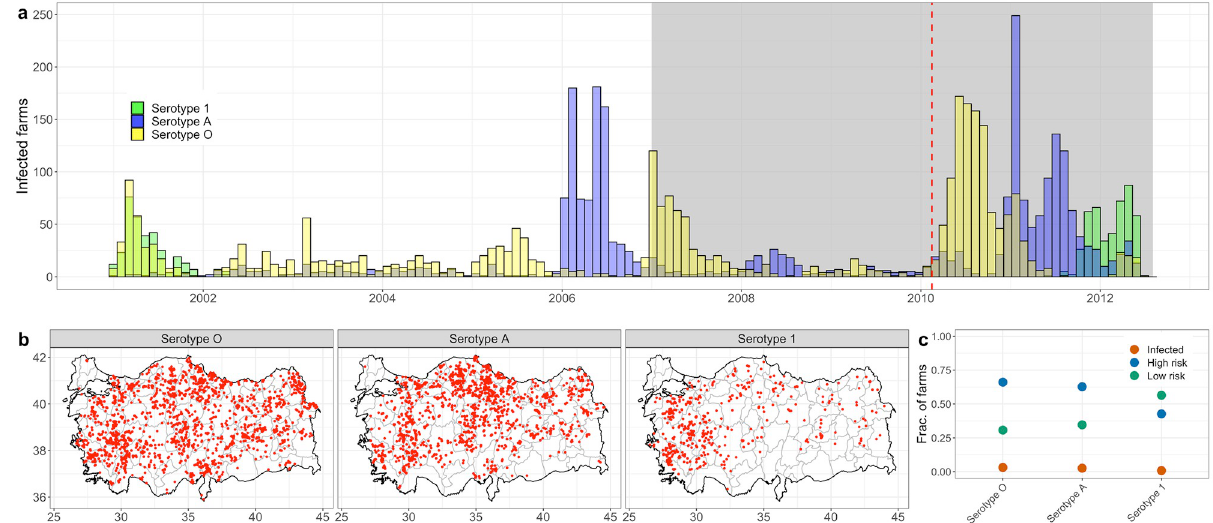
Fig 3. a . Incidence (accumulated by month) of each strain of FMD in Turkey. The gray region shows the time range where the outbreak data and the shipments data overlap (2007—2012). The red dashed vertical line delineates the endemic (left) and epidemic (right) regions, regardless of serotype, at February 15, 2010. b . Maps of Turkey showing the location of each of the epiunits (red points) where there occurred an outbreak of FMD. Each panel shows the location of epiunits where occurred at least one outbreak, according to serotype. c . Fraction of epiunits in each state (infected (red), High risk (blue) and Low risk (green), for each FMD serotype. Base layer of maps available from https://gadm.org/download_country.html with license https:// gadm.org/license.html.